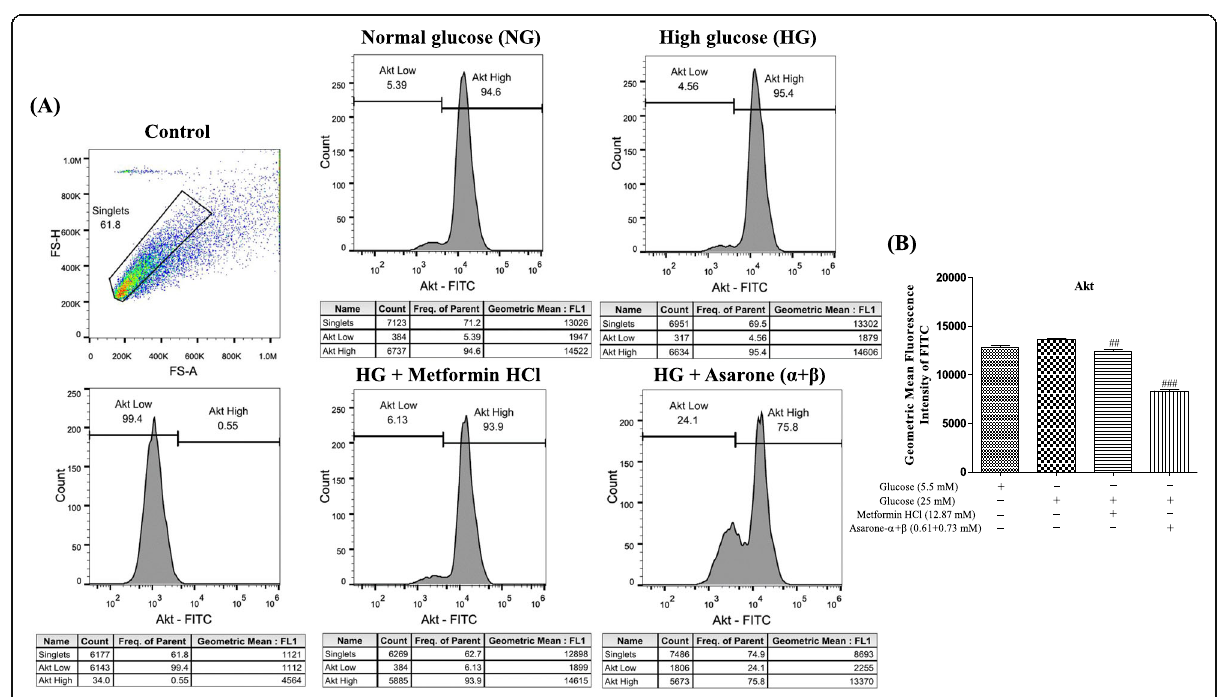
Fig. 7 The treatment of high glucose-promoted HepG2 cells with metformin and asarone downregulates the expression of Akt. a A representative flow cytometry histogram events depicting the expression of Akt cultured in normal glucose (NG; 5.5 mM), high glucose (HG; 25 mM), HG + Metformin HCl, and HG + Asarone. b Bar diagrams represent geometric mean fluorescence intensity (GMFI) of Akt in HepG2 cells. Values represent mean ± SEM of an experiment done in triplicate; one-way ANOVA followed by Bonferroni test, where ## p < 0.01 and ### p < 0.001 compared to the high glucose (HG)